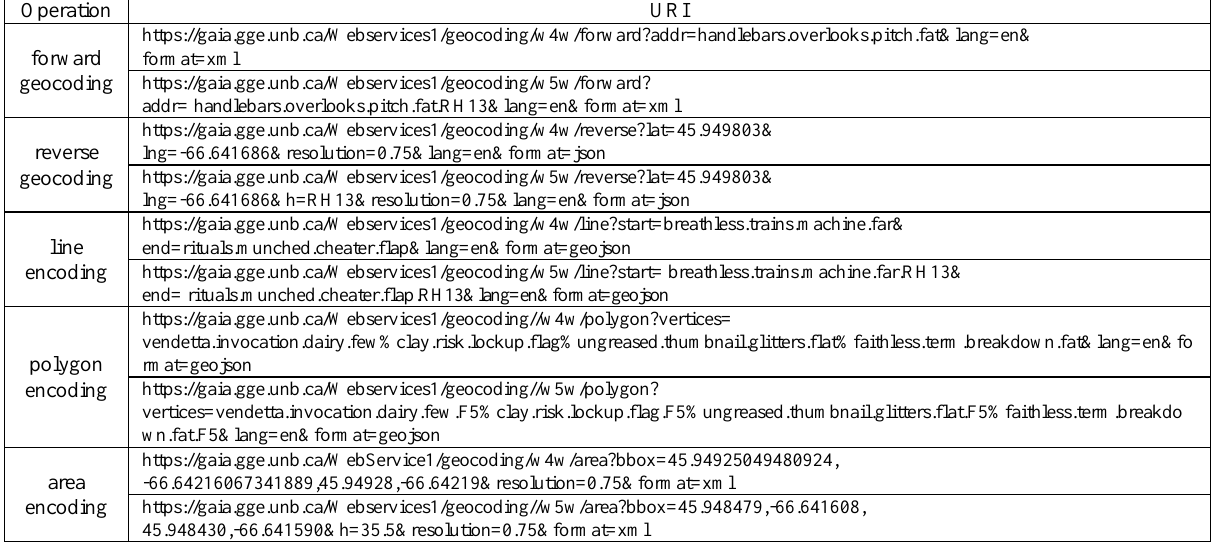
Table 10 Extended w3w RESTful API operations and example URIs